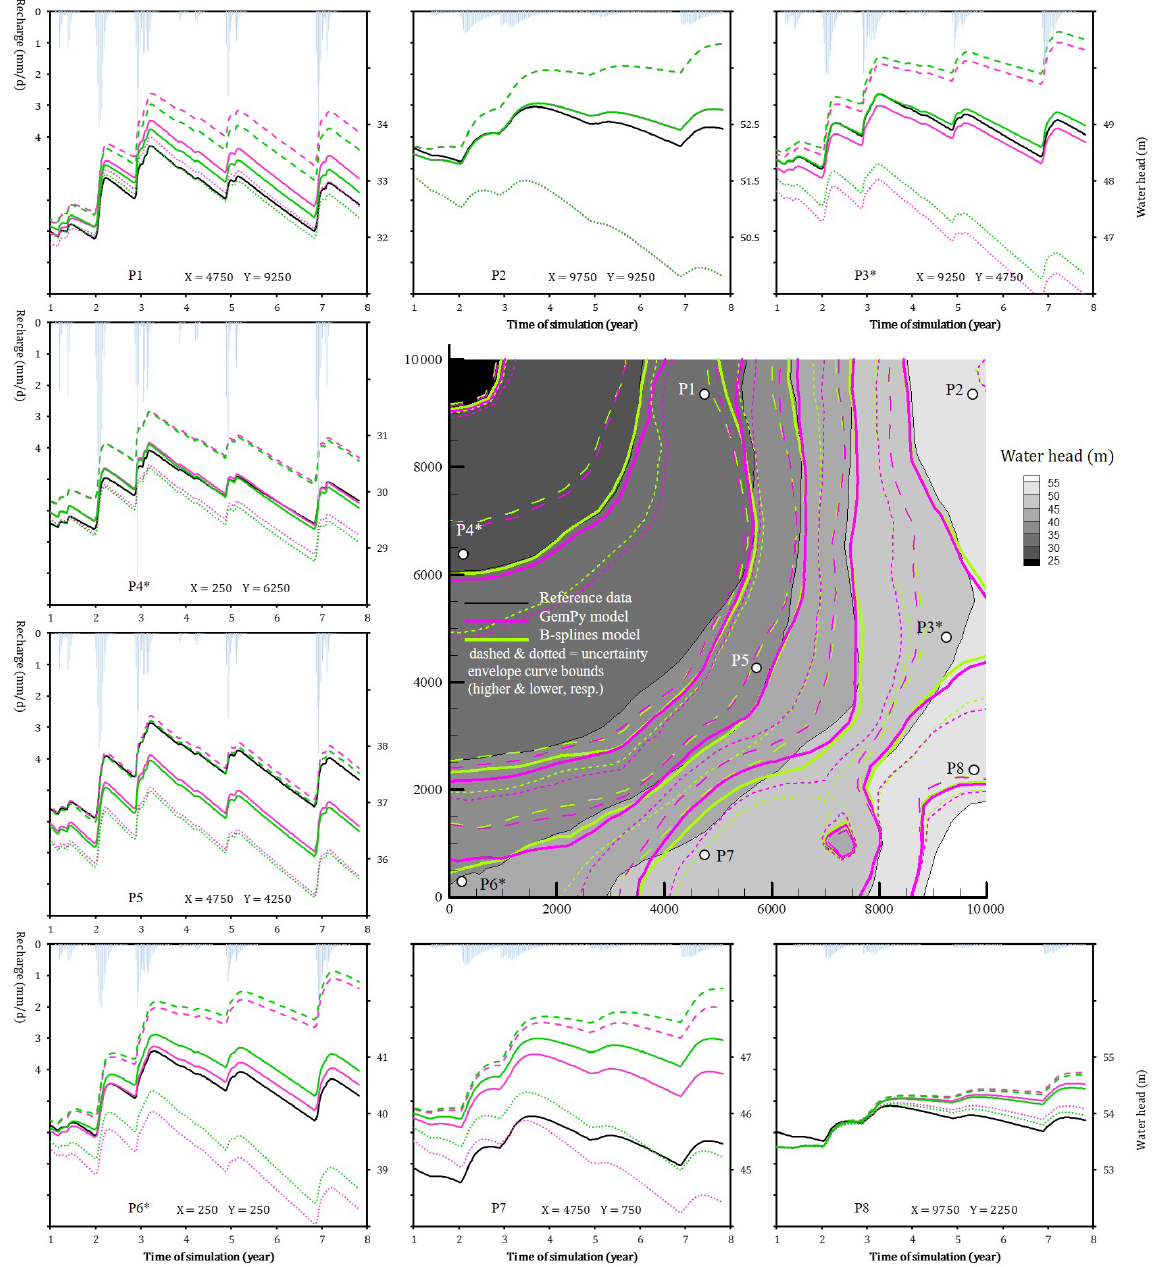
Figure 8. Comparisons of the 3D piezometric head variations. Piezometric head values (chronicles and map) are differentiated by colours (black: reference model, purple: GemPy, green: B-splines). The dashed and dotted lines give the uncertainty